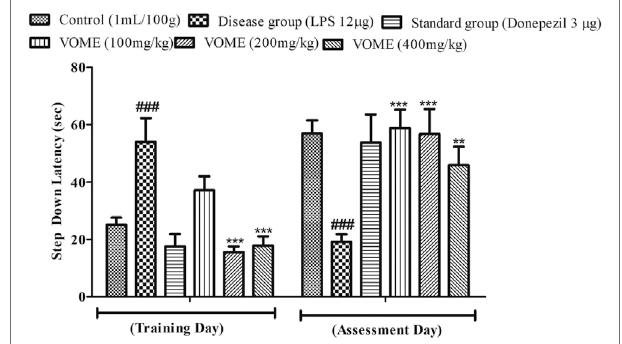
FIGURE 6 | Histogram presenting the effect of Viola odorata methanolic extract on the step-down latency (sec) in the passive avoidance test in mice.